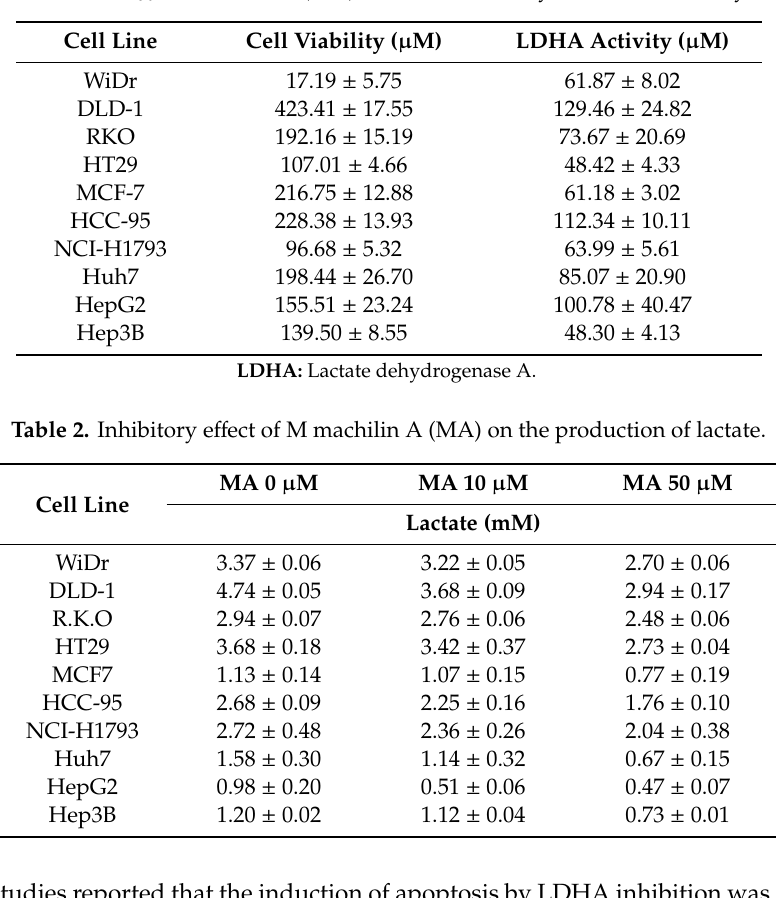
Table 1. IC 50 of machilin A (MA) on the cell viability and LDHA activity.